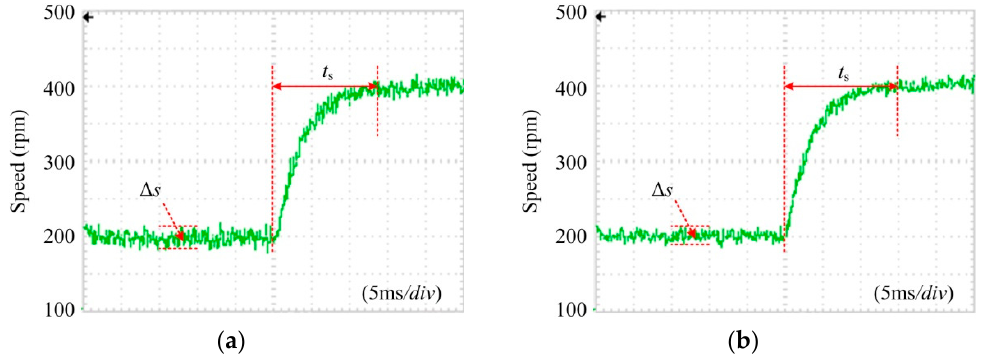
Figure 15. The speed trajectory is from 200 rpm to 400 rpm when using: ( a ) NDTC; ( b ) FS-NDTC.